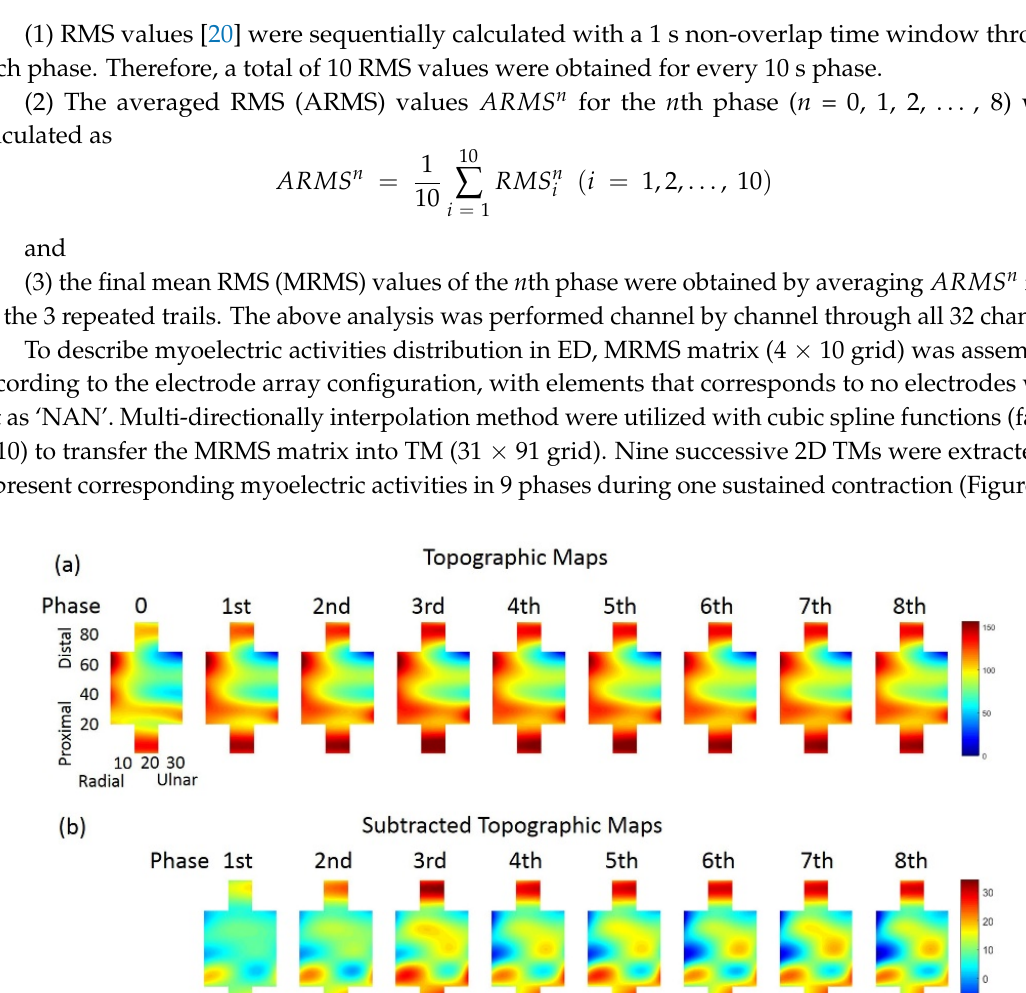
Figure 4. Hot regions, warm regions and cool regions at 8 phases during sustained index extension ( same subject as Figure 3). To analyze the change trend of three different regions in STMs, corresponding region areas were computed through pixel number counts. Then, all region areas (hot, warm, cool regions, respectively) of STMs ( (cid:1856)(cid:1839) (cid:3041) ) was normalized to the corresponding areas within the STM of the first phase ( (cid:1856)(cid:1839) (cid:2869) ). We defined the relative normalized regional area as follows: (cid:1827)(cid:1844) (cid:3041) = (cid:1827) (cid:3041) (cid:1827) (cid:2869) (5)